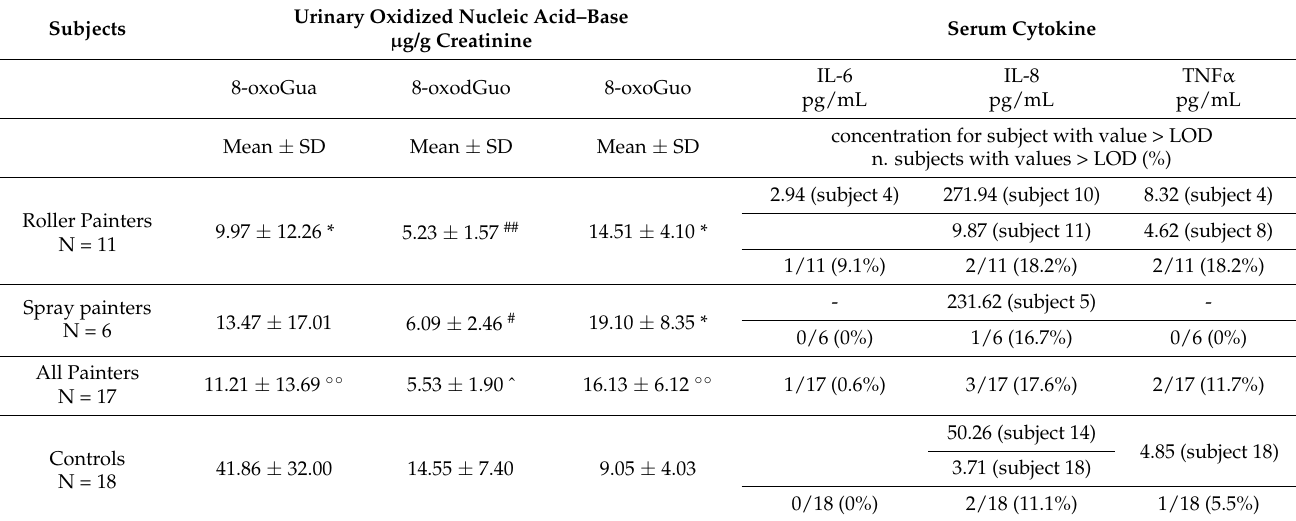
Table 7. Oxidative stress and